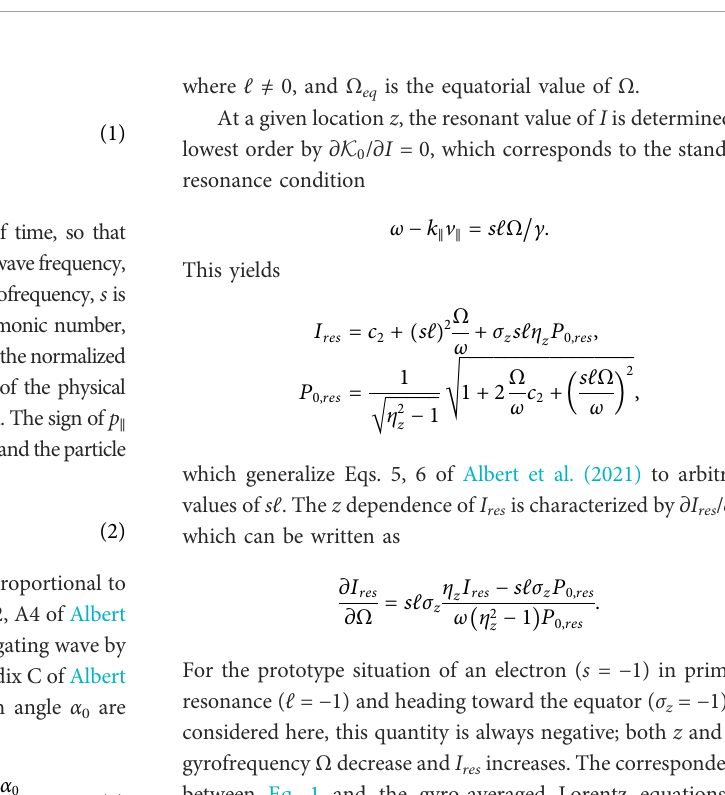
Trajectories of 120 particles from numerical integration of the equations of motion speci fi ed by the Hamiltonian of Eq. 11, with inhomogeneity parameter R = 0.2 and wave amplitude parameter A = 0.25. Left: P vs. t , showing systematic decrease associated with phase bunching at resonance. In this case, most but not all values of Δ P are negative. Right: Change in P vs. the value of q at resonance. The dotted and dashed vertical lines show the calculated values q turn and q x + 2 π , respectively, as discussed in the